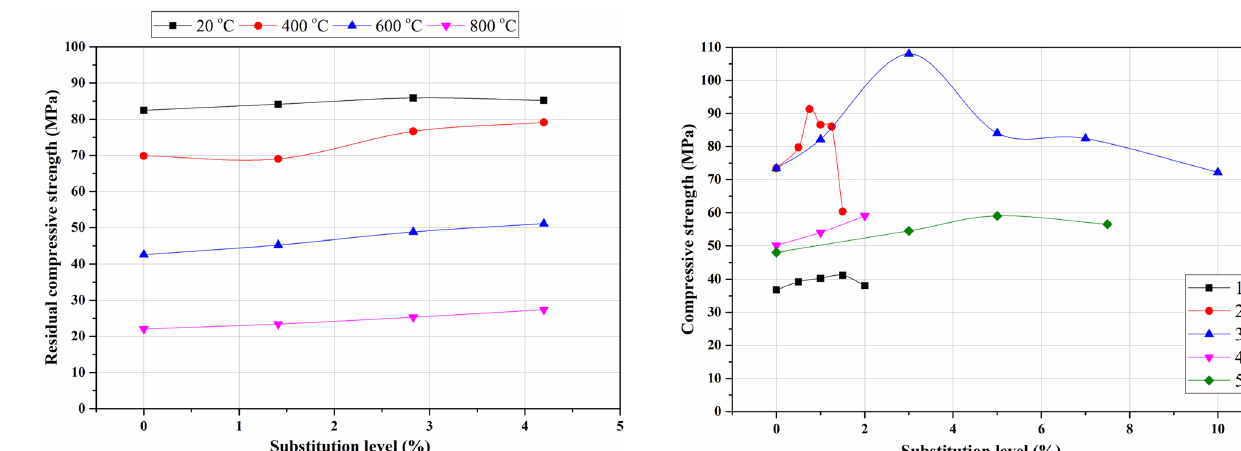
[12]; (2): nano- 2 [46]; (5): nano-SiO 2 2